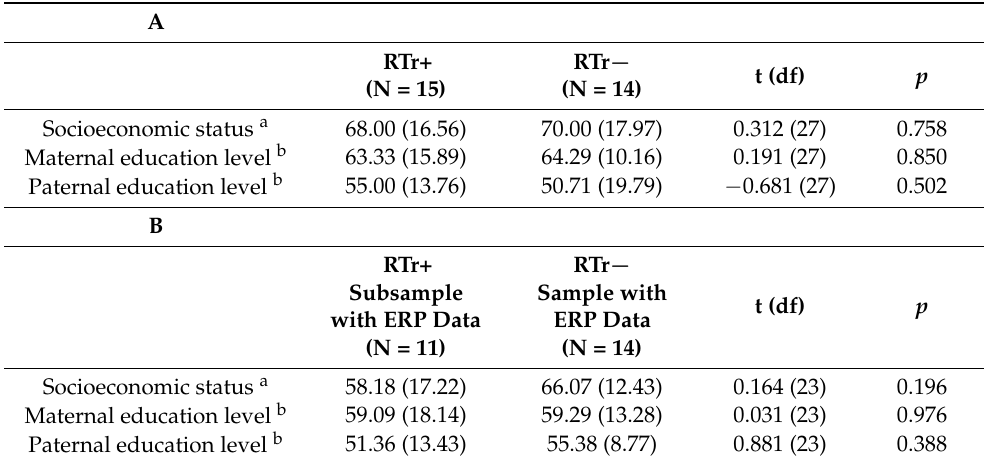
Table 1. Descriptive statistics: Mean (standard deviation) and group comparison of sociodemographic